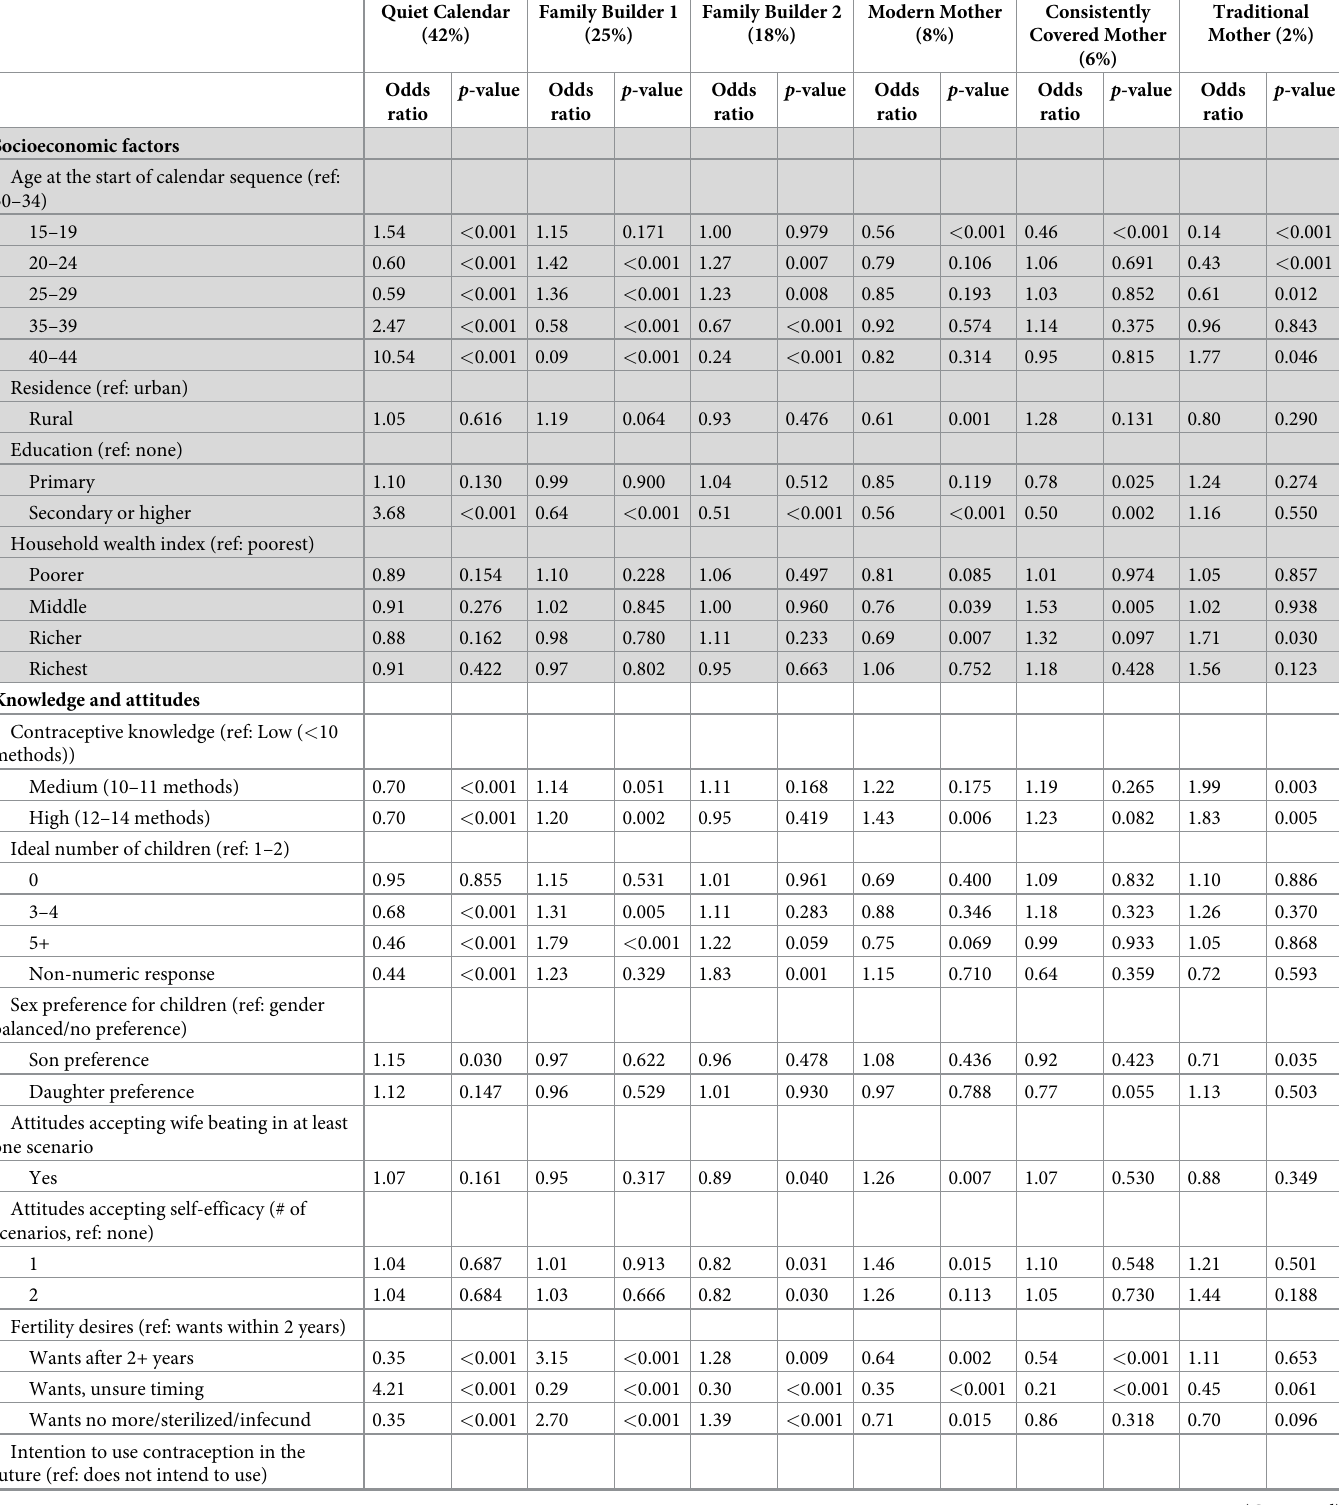
Table 2. Knowledge, attitudes, and media and health service interactions associated with cluster membership. Odds ratios from logistic